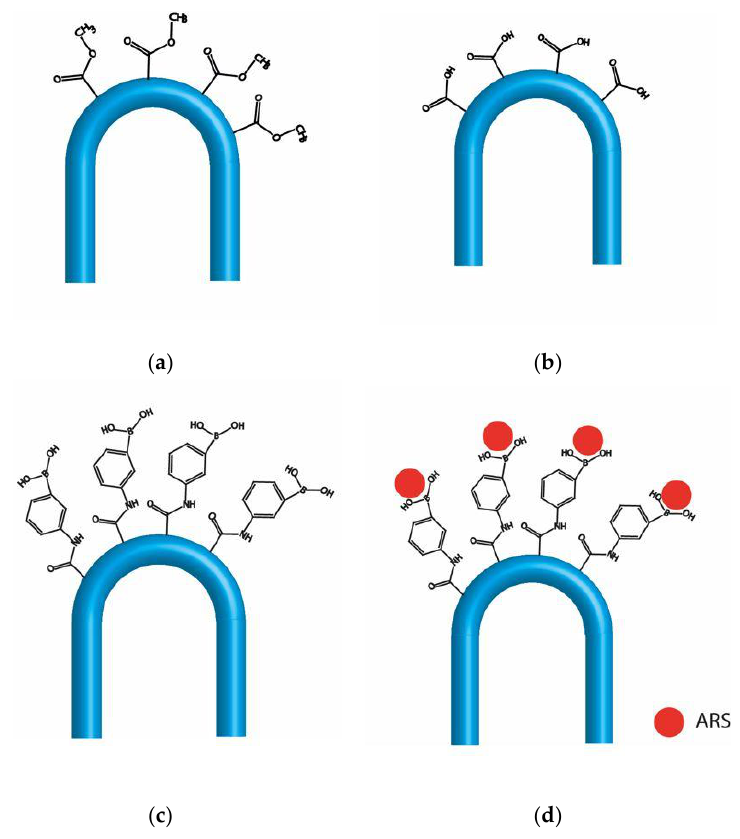
Figure 5. Functionalization process of the probe: ( a ) initial poly(methyl methacrylate) (PMMA) probe; ( b ) hydrolyzed probe; ( c ) PBA functionalized probe; ( d ) ARS charged probe.